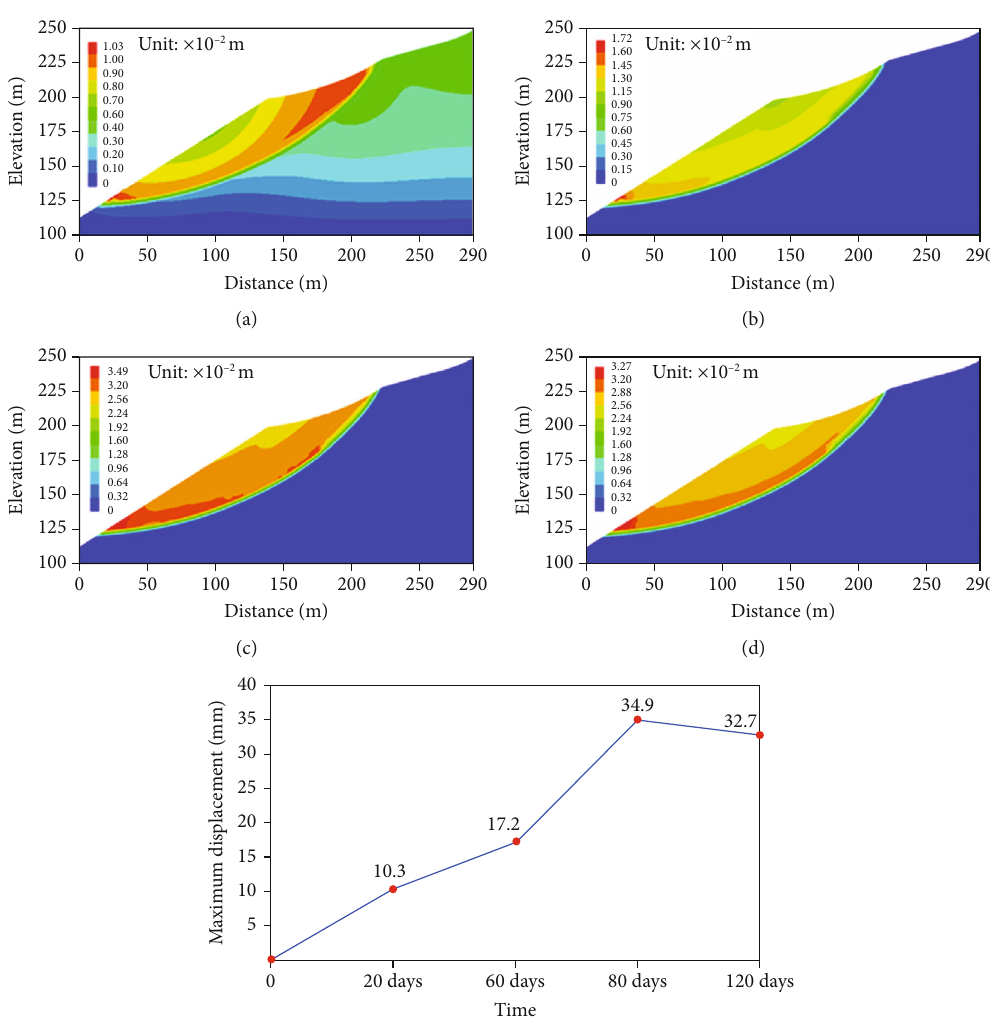
Figure 9: Maximum displacement distribution with the changing of reservoir water level: (a) 20 days, (b) 60 days, (c) 80 days, and (d) 120 days; (e) trend of maximum displacement over